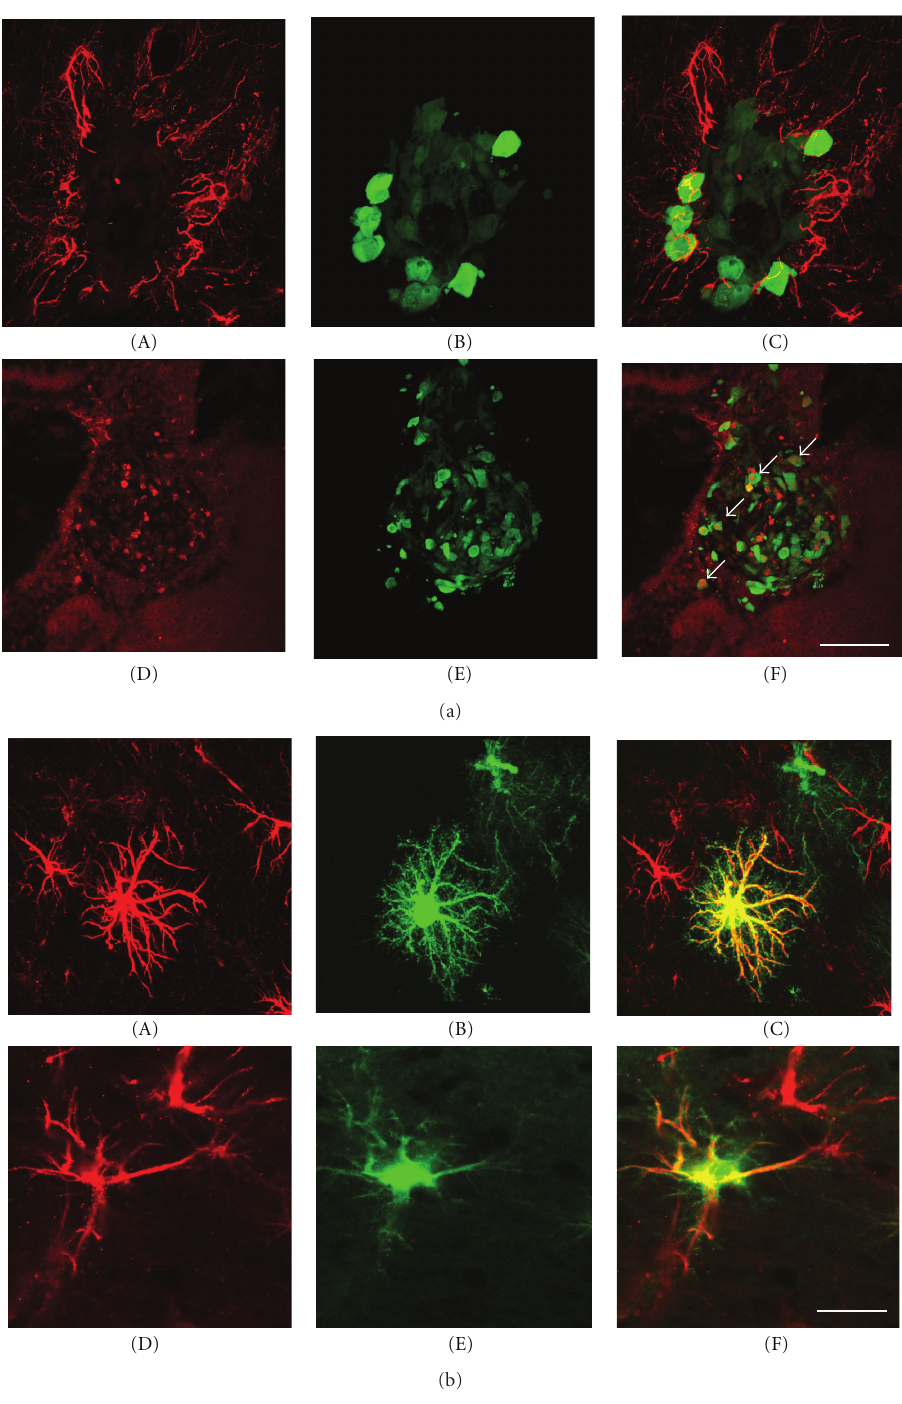
Figure 4: Engraftment of human ATSCs within newborn rat brain. (a) Confocal microscopy micrographs showing the engraftment of eGFP- positive (green; A, D) ATSCs within newborn rat brain 1 week after cell infusion. ATSCs exhibit a round morphology (A, C), are surrounded by GFAP-positive astrocytes (red; B, D), and express TRKA (red, B, D, arrows). (b) Engraftment and in vivo di ff erentiation of human ATSCs within newborn rat hippocampus 2 weeks after implantation. Confocal images of GFAP (red; A) or TRKA (red; D) immunolabeled eGFP (green; B, E) expressing ATSCs. Engrafted cells express the astrocytic marker GFAP (yellow, C) and the TRKA receptor (yellow, F).